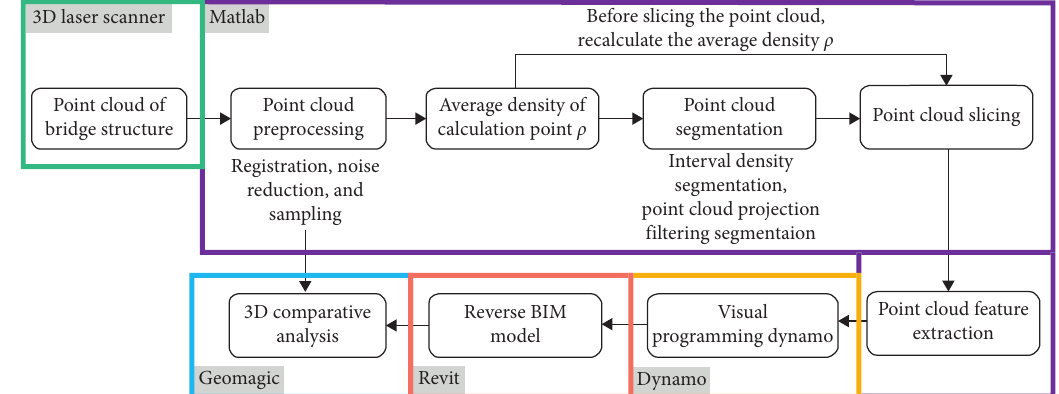
Figure 1: Flow chart of automatic realization from point cloud to BIM.